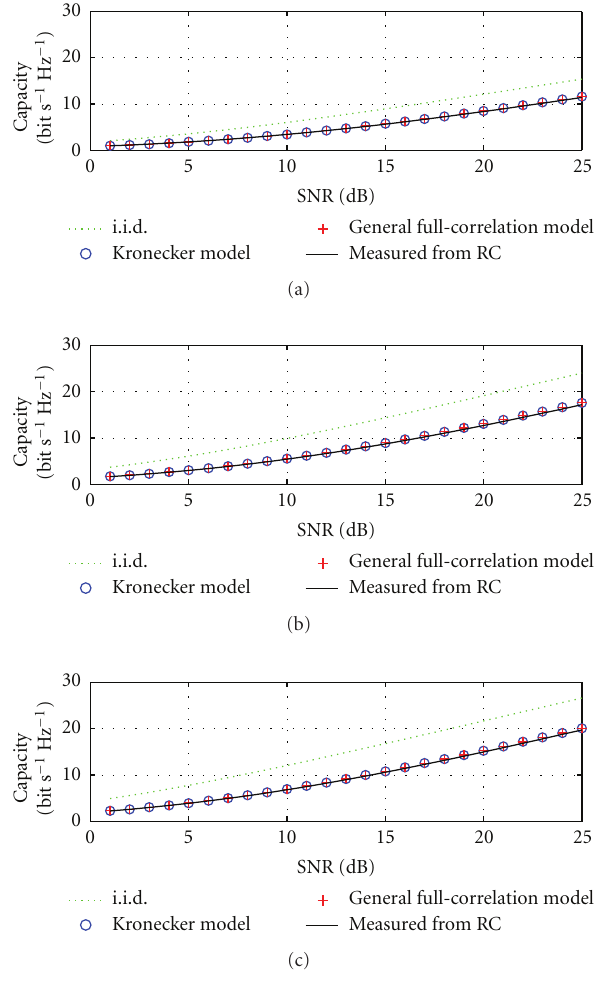
Figure 3: Comparison of the Kronecker model and full-correlation model against reverberation chamber measurement of 2 × 3 (a), 4 × 3 (b), and 6 × 3 (c) MIMO ergodic capacities, all at 900